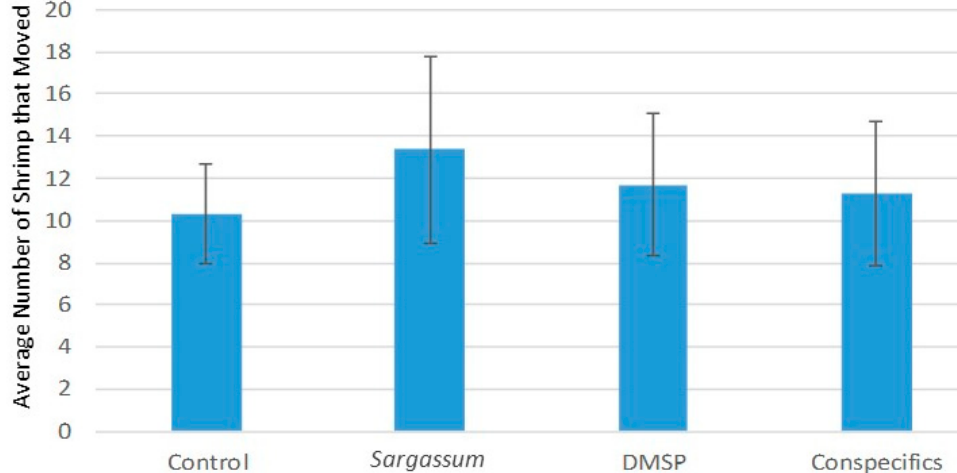
Figure 3. Average number of Latreutes fucorum shrimp that moved out of the central chamber of the 4-chambered apparatus for the control, Sargassum , DMSP and conspecifics trials (one-way ANOVA, p = 0.14). Post hoc T -test comparing the number of shrimp moving in the chemical presence of Sargassum (13.36) was slightly higher than in the control trials (10.29) ( p = 0.03). Error bars indicate standard deviations.